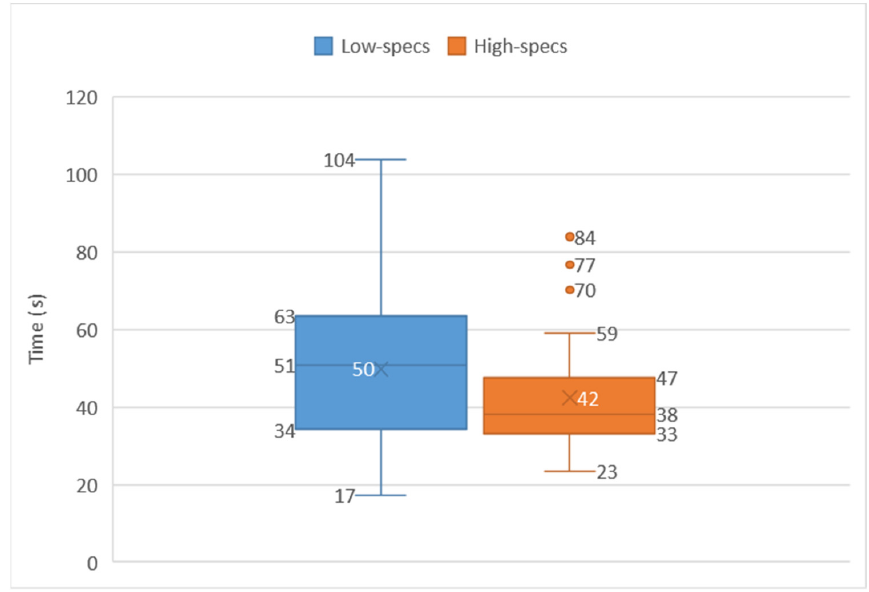
Figure 11. Time spent by participants to calibrate the